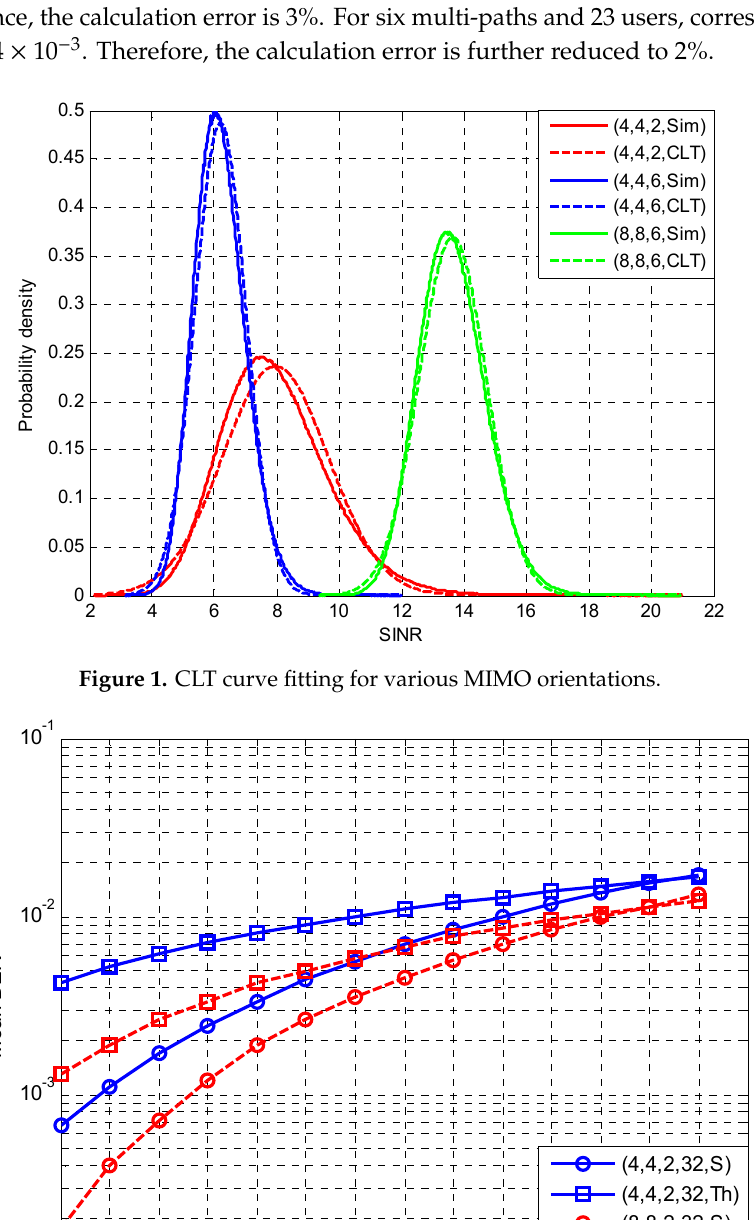
Figure 3. BER values for increased diversity order MIMO orientations. 5. Conclusions The performance of MIMO SM orientations was analyzed, in terms of achievable BERs. In this context, desired user signal and total interference were expressed in terms of summation of identically distributed random variables, which reduces computational complexity. As the results indicate, the calculation error is minimized for high diversity multi-user MIMO orientations. Knowledge of uncoded BER is particularly important for the design of next generation broadband